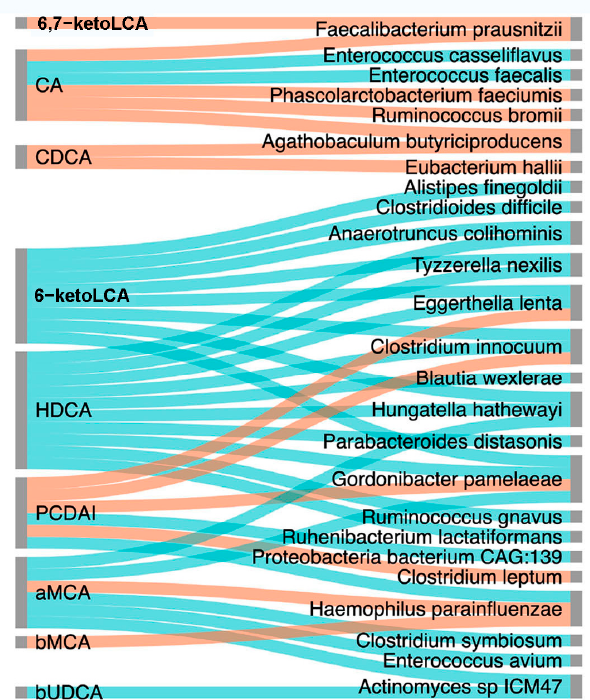
Figure 9. Interrelationships among bile acid profiles, PCDAI and gut microbiota. Sankey plot constructed using NAMAP with Spearman’s rank correlations between PCDAI, gut microbiota (species level), and fecal BAs that were significantly enriched after EEN induction therapy. The network shows associations that are statistically significant with a cutoff of p < 0.05 and r > 0.7 based on bootstrapping of 100 iterations. Direct correlations are indicated as blue edges and inverse correlations as red edges. 6,7 − ketoLCA, 6,7 − ketolithocholic acid; CA, cholic acid; CDCA, chenodeoxycholic acid; 6 − ketoLCA, 6 − ketolithocholic acid; HDCA, α− hyodeoxycholic acid; PCDAI, Pediatric Crohn’s Disease Activity Index; aMCA, α− muricholic acid; β MCA, β− muricholic acid; bUDCA, 3 β− ursodeoxycholic acid.